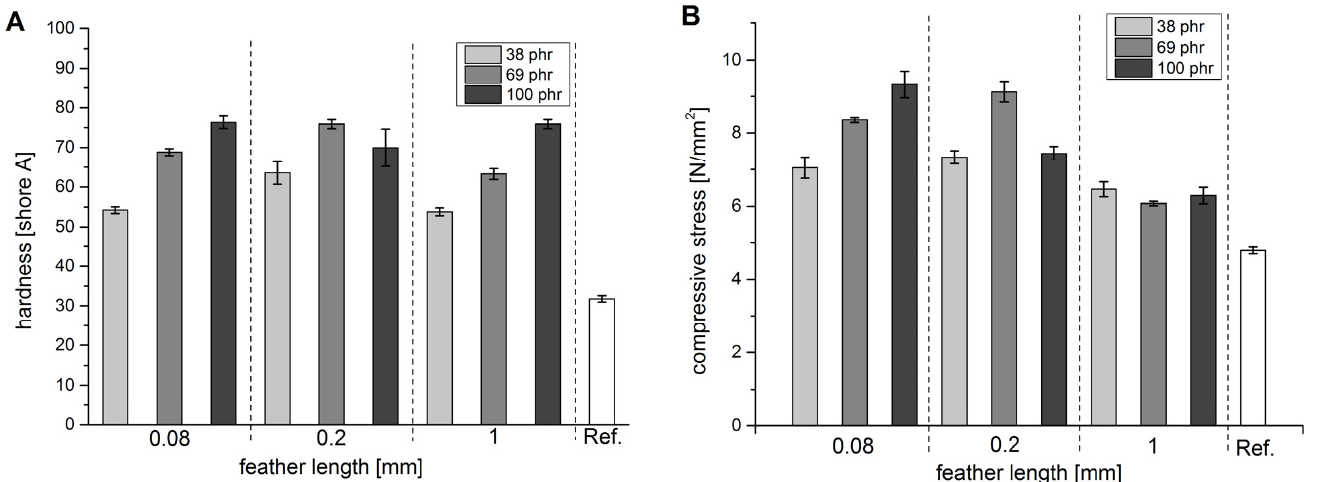
Figure 3. Hardness of the vulcanised M1 mixture with increasing amount of feather cuttings ( A ); compressive stress measured under uniaxial compression to 40% of the original height of the sample ( B ). A vulcanised M1 mixture without feathers is used as reference. Specimens were prepared from 5 mm thick samples.